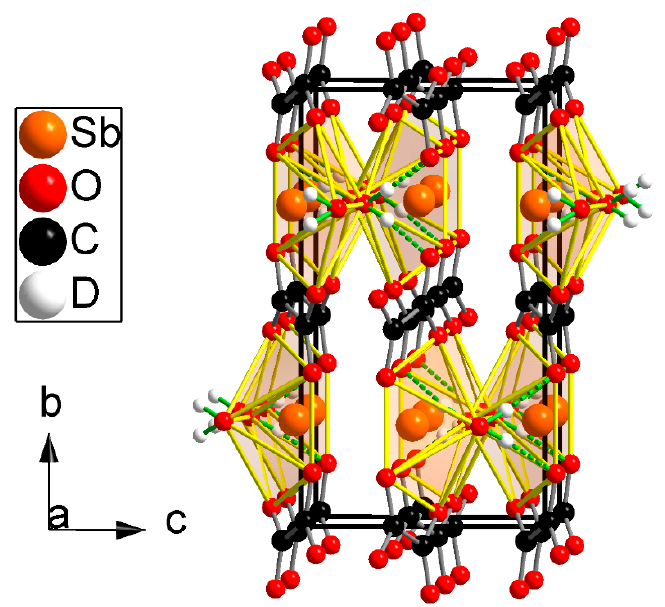
Figure 8. Crystal structure of SbC 2 O 4 OD as determined from neutron powder di ff raction showing zigzag chains of pentagonal SbO 6 pyramids along [100] linked by OD groups (split position for D atoms with half occupation) and oxalate anion bridging the chains. Selected interatomic distances are